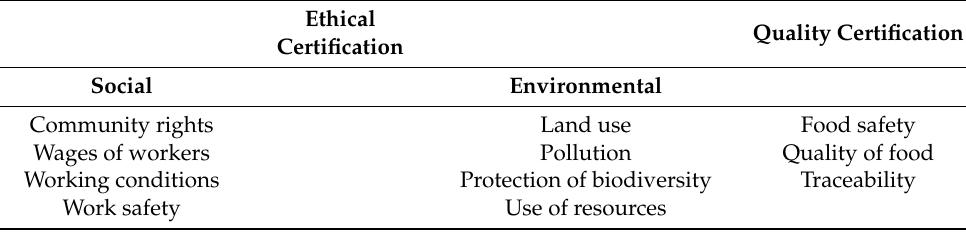
Table 14. Certification methods used in the aquaculture